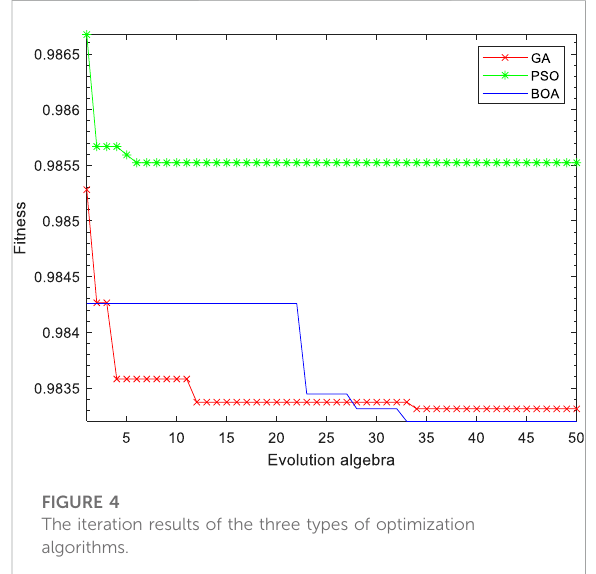
FIGURE 4 The iteration results of the three types of optimization algorithms.